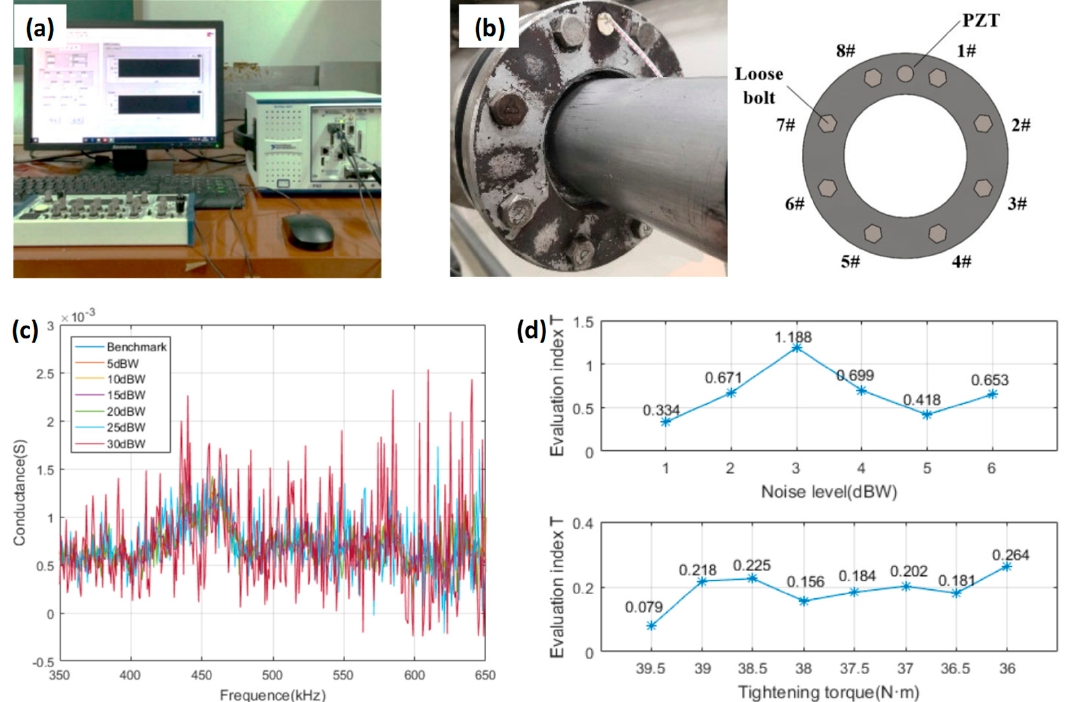
Figure 12. Impedance-based SHM of a bolted flange ( a ) impedance analyzer, ( b ) PZT mounted on an eight-bolt flange and layout diagram, ( c ) noise effect on the conductance, and ( d ) evaluation index under different working conditions (adapted from [102] ).